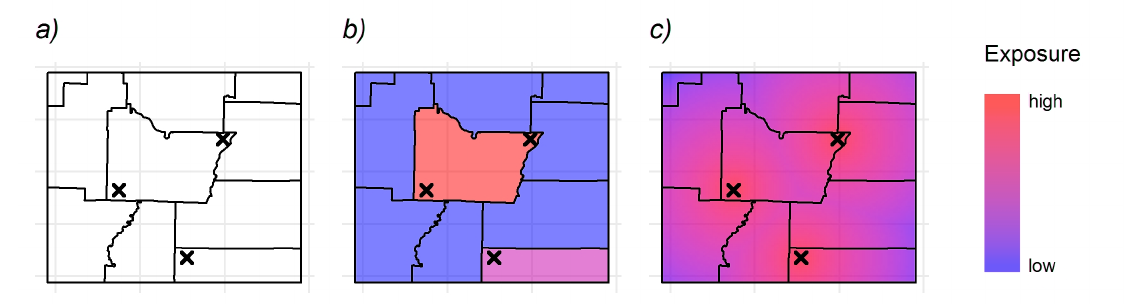
Figure 1. Schematic depiction of the problem of boundary effects with three emission sources (x) and administrative areal units. ( a ) presents the distribution of the point locations within the areal units. ( b ) depicts the environmental exposure by occurrence within each administrative unit (hazard-unit coincidence). ( c ) visualizes a simple spatially continuous distance based method of the impact of the hazardous sites on the surrounding independent of spatial